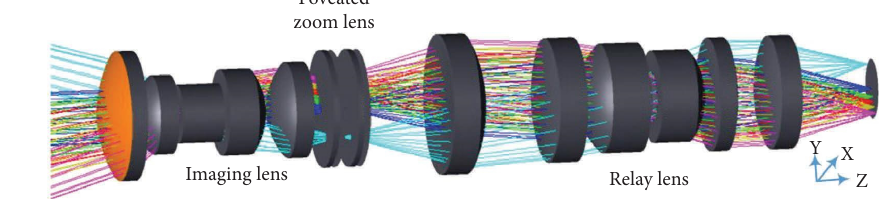
Figure 3: Optical layouts of LSHI.